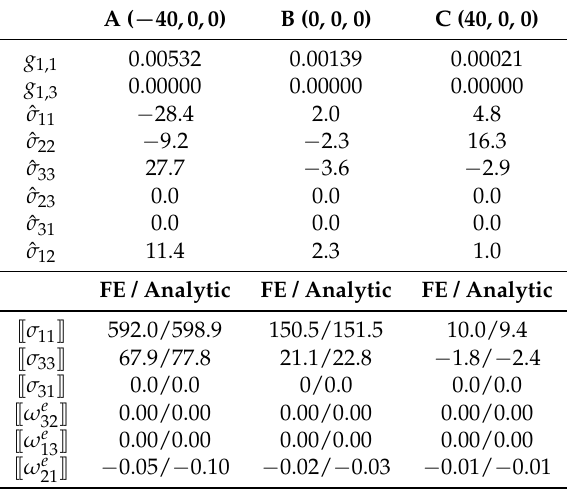
]] (MPa) and [[ ω e ]] ( ◦ ) given by the FE ∼ ∼